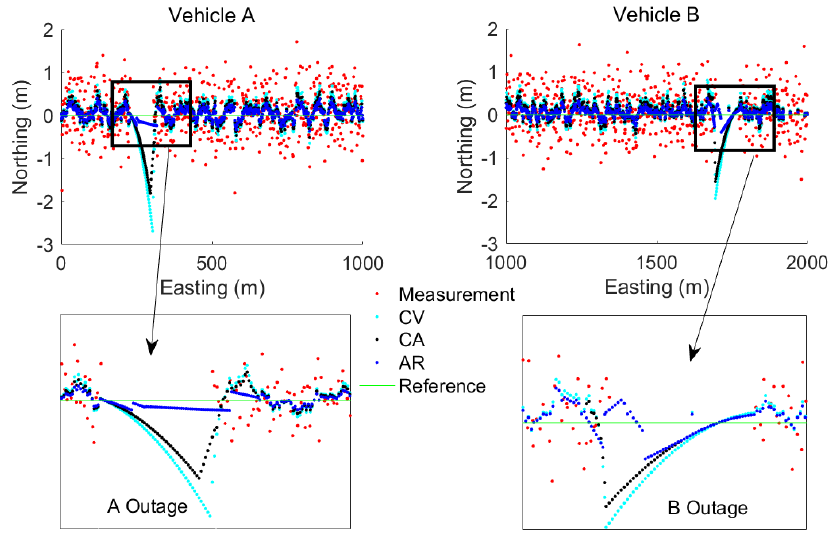
Figure 4. An example of fusion model estimated results for TC1 with head-on collision type.